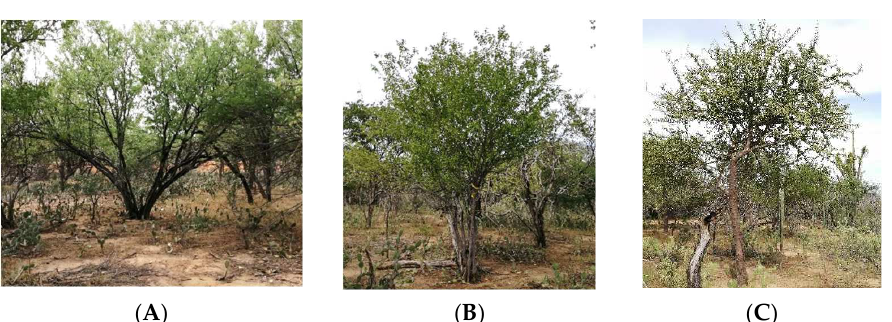
Figure A1. Fertile area under the canopy of the tree nurse species ( A ) Haematoxylum brasiletto , ( B ) Pithecellobium dulce , and ( C ) Pereskia guamacho . These species facilitate the growth of understory plants and the formation of resource islands in the Indigenous Cerrejón Guajira Foundation Farm in the municipality of Uribia, Department of La Guajira, Colombia.